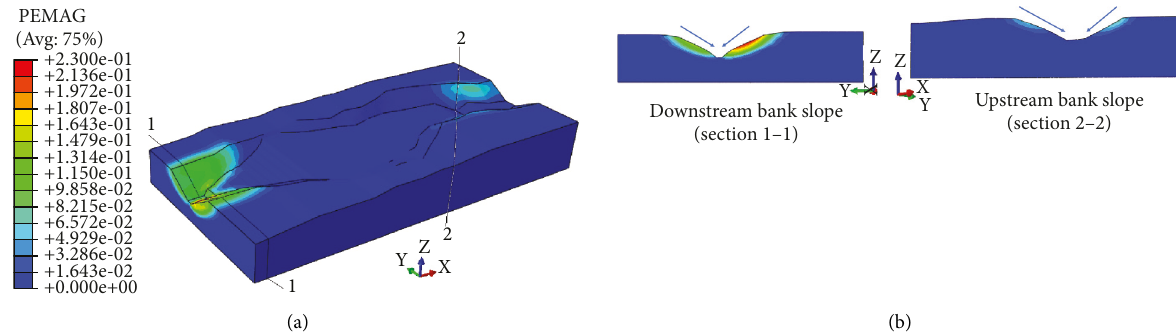
Figure 17: (a) The plastic zone of critical buckling destruction of landfill slope in Scheme 4-1. (b) The landslide form of critical buckling destruction of bank slope in Scheme 7 (the deformation scale factor is